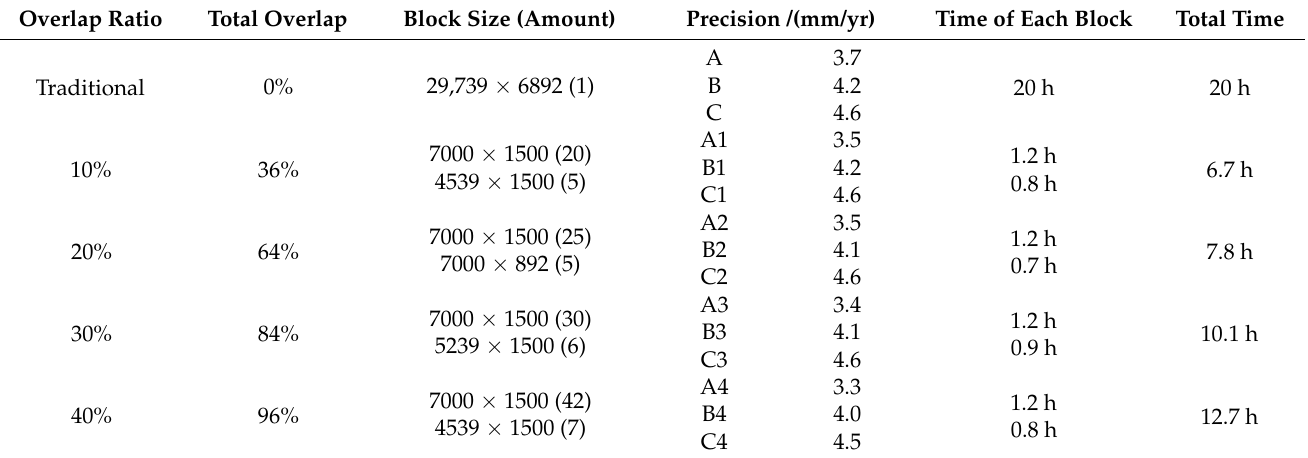
Table 4. Results of using different block overlap